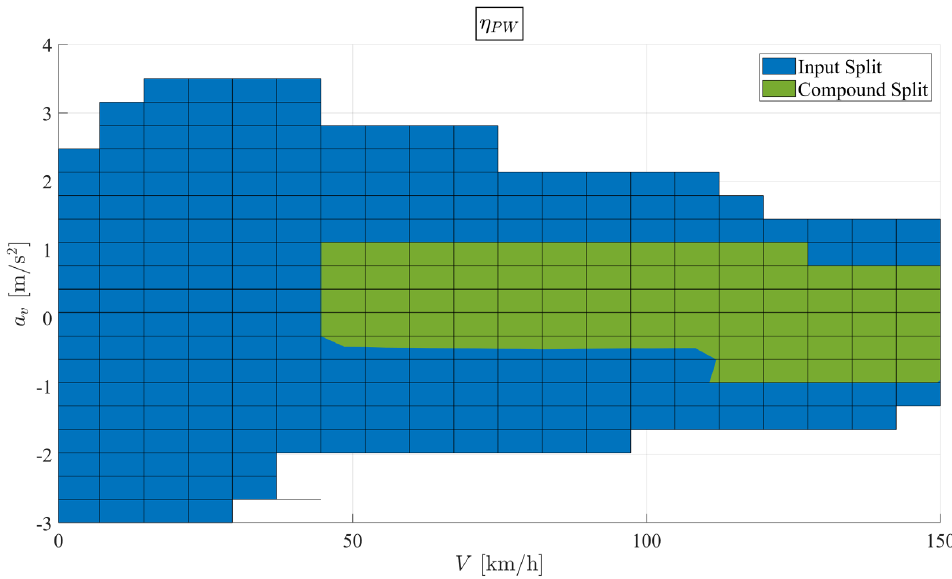
Figure 10. Resulting powertrain mode map for the two-mode hybrid system with road slope α = 0.